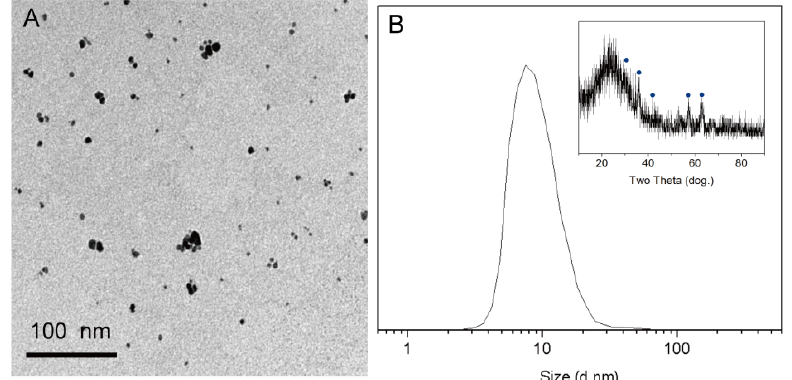
Figure 2: Characterization of nanoparticles: TEM (A) and DLS (B) images of Fe 3 O 4 NPs with 9nm particle sizes; the inserted image is the XRD image